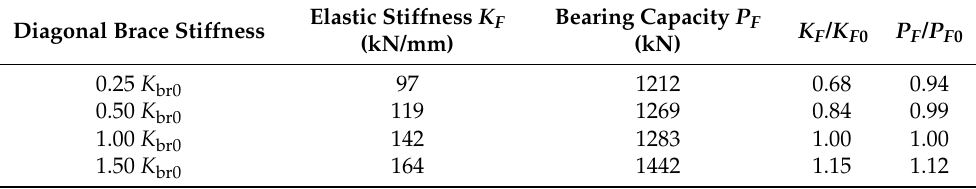
Figure 26. Stress nephograms of a concrete slab for different K br values. Table 8. Comparison of mechanical properties for different K br